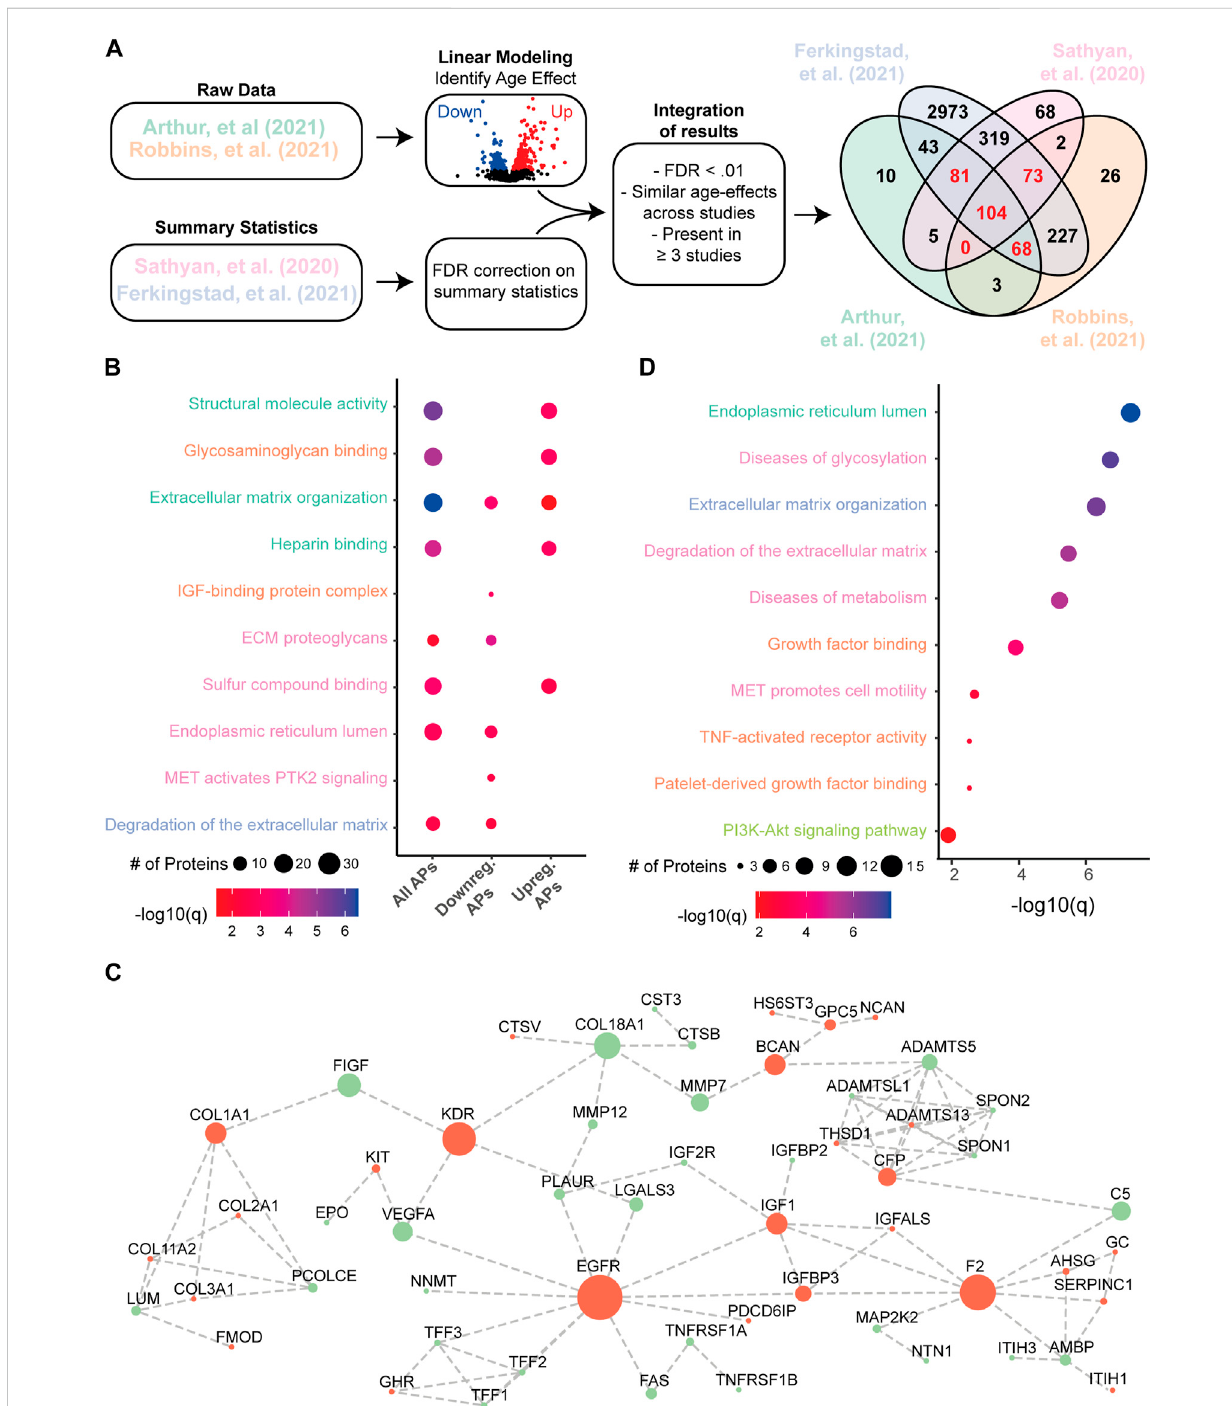
FIGURE 1 Identi fi cation of plasma proteins associated with aging. (A) Work fl ow and selection criteria used for the identi fi cation of APs. The Venn diagram depicts the results of the integration across datasets. Highlighted in red are 326 proteins with signi fi cant differences (FDR < .01) in ≥ 3 different studies, of which 273 APs showed similar age-associated effects across all studies. (B) Overview displaying a wide variety of signi fi cant functional enrichments of all APs,andthesubsetsofalldownregulatedAPsandallupregulatedAPs.Dotsizerepresentsthenumberofproteinsinvolved,anddotcolorrepresents signi fi cance levels as -log10(FDR). Terms are color coded based on database: Green = Gene Ontology (GO)-Cellular Component, Orange = GO- Molecular Function, Blue = GO-Biological Process, Pink = REACTOME database. A full overview is presented in Supplementary Table S4. (C) Visual representation of the protein-protein interaction (PPI) network of a highly interconnected subnetwork within all APs, consisting of 56 APs. Red nodes indicatedecreasedexpressionlevelsintheplasmaduringagingandgreennodesindicateincreasedplasmaexpressionlevelsduringaging.Sizesofnodes re fl ect the number of connections to other proteins. (D) Overview displaying the various enriched terms of the PPI-subnetwork. Dot sizes and colors represent similar properties as described in panel (B) . Terms are color coded based on database as described in panel (B) , with the addition of light green for the KEGG